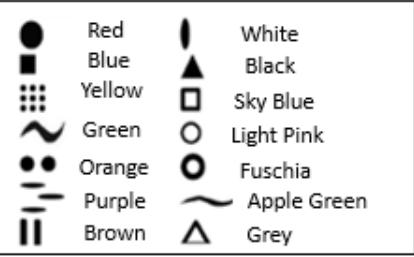
Figure 6. Ramsamy-Iranah system. Source: Ramsamy-Iranah, 2016.